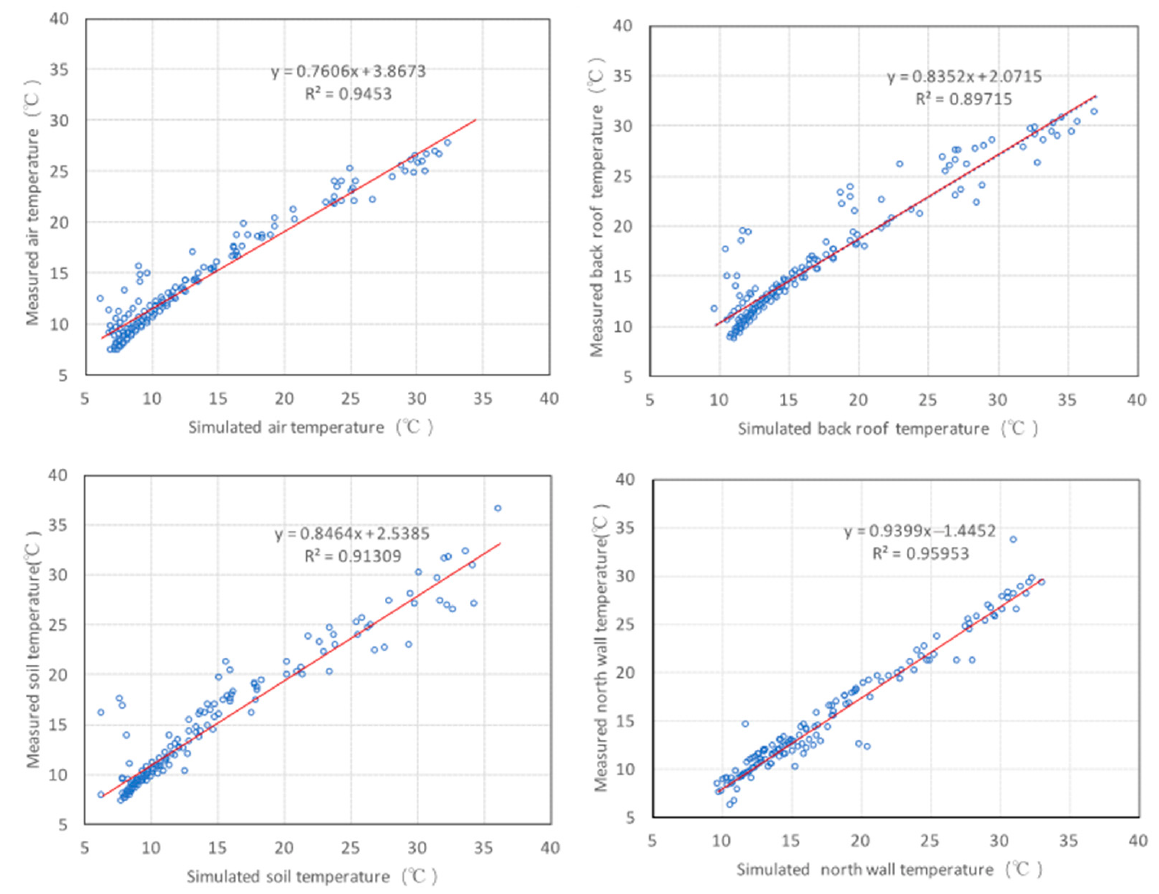
Figure 14. Relationship between simulated and measured temperature variations during clear days.